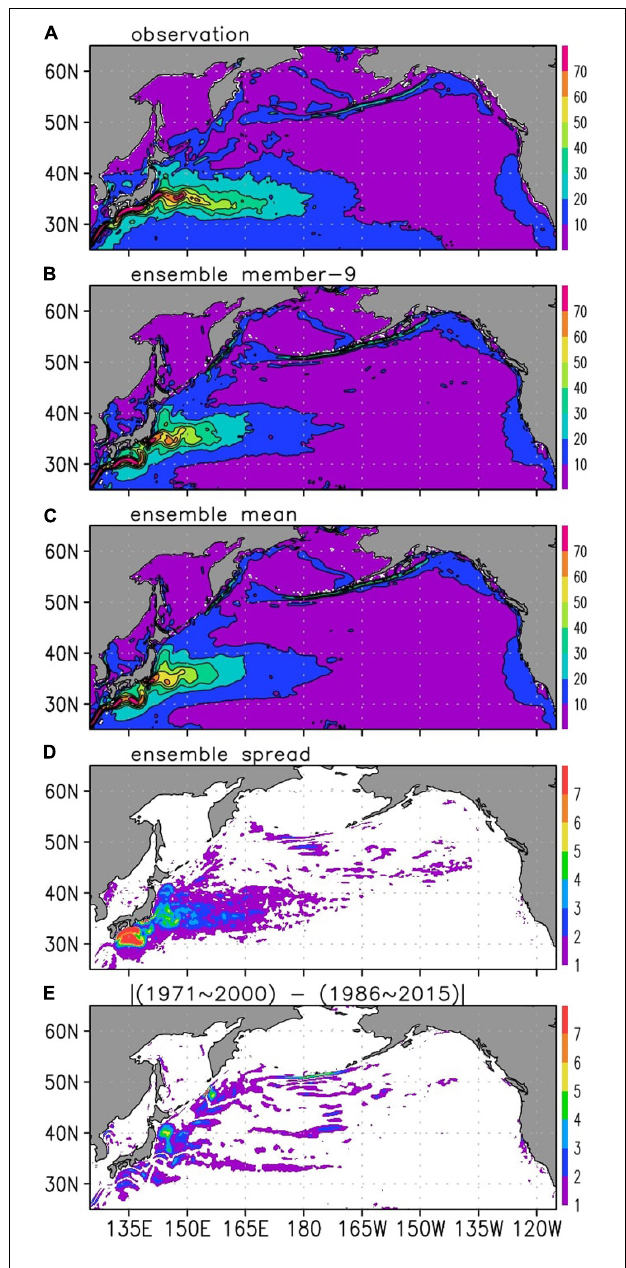
FIGURE 2 | (A) Horizontal map of the long-term (1993–2018) mean observed surface current speed. (B,C) Same as the top panel but for panel (B) the ensemble member with the largest current speed in the KE jet (30–40N, east of 141E) and (C) the ensemble mean of the simulated field averaged for the periods (1986–2015). (D) Same as panel (C) but for the ensemble spread. (E) Absolute value of difference between two long-term mean simulated surface current fields for the periods of (1971–2000) and (1986–2015). Unit is cm s − 1